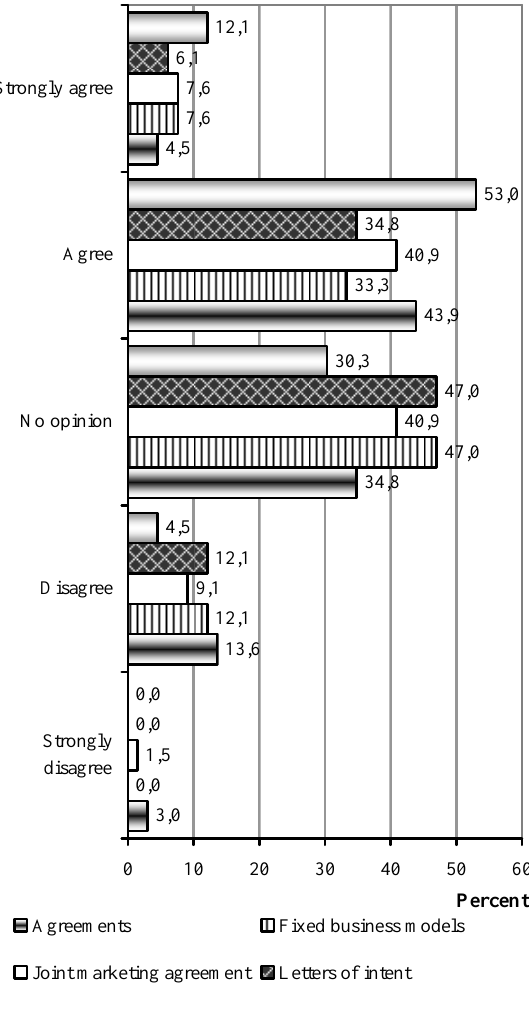
Fig 3. Framework of logistics networking in BSR